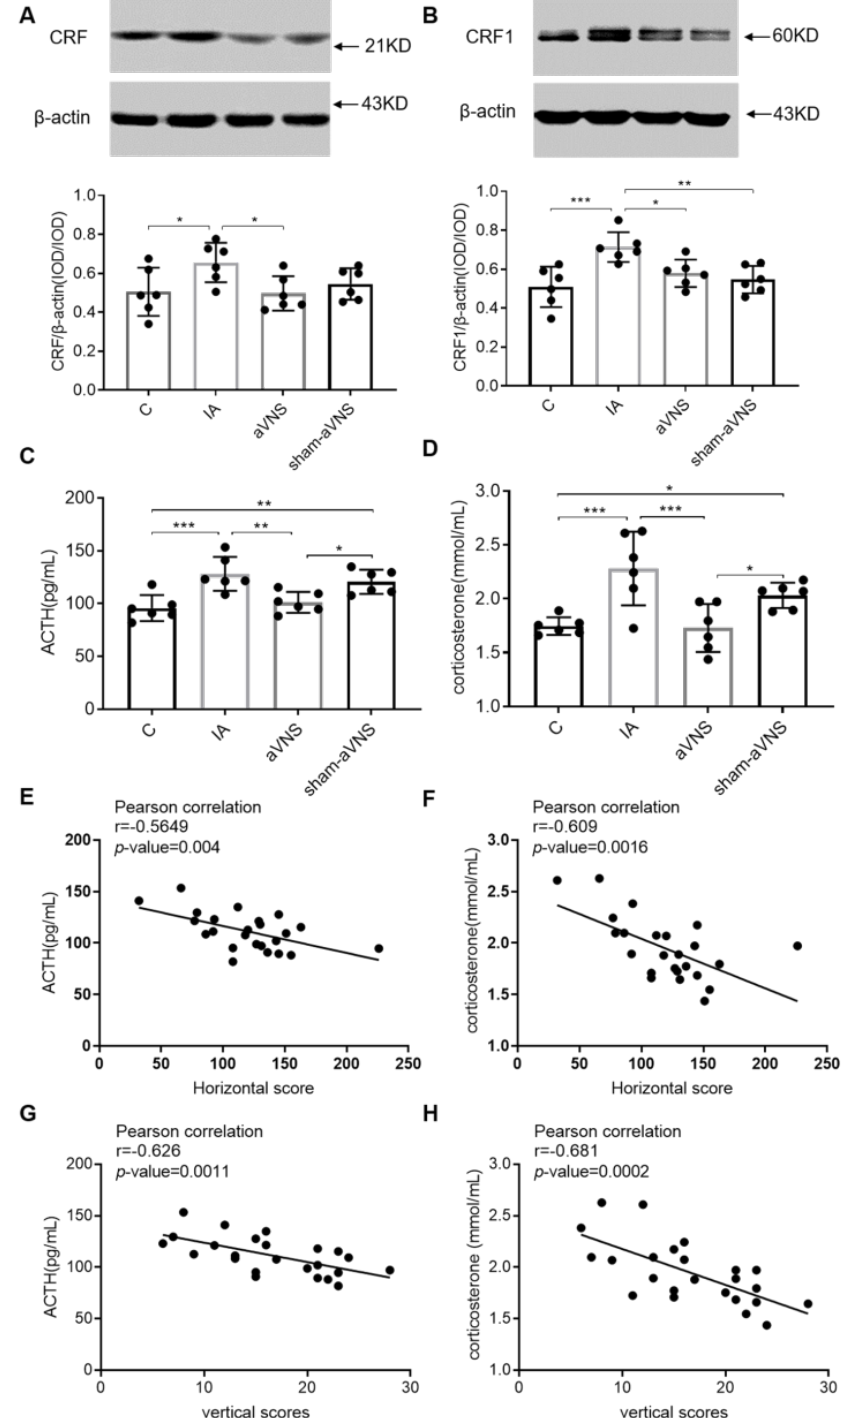
Figure 6. The hypothalamic–pituitary–adrenal axis mechanism of the intervention. ( A ) Expression of hypothalamus CRF in all rats. ( B ) Expression of amygdaloid nucleus CRF1 in all rats. ( C , D ) The release of serum ACTH and corticosterone in all rats. One-way ANOVA was used, and the LSD method was used for post hoc tests for all. ( E – H ): Pearson correlation analysis between HPA axis and OFT. * p < 0.05, ** p < 0.01, *** p < 0.001. ACTH: adrenocorticotropic hormone. CRF: corticotropin releasing factor. C: control group; IA: IA-treated group. n = 6 per group. Data were presented as means ± standard